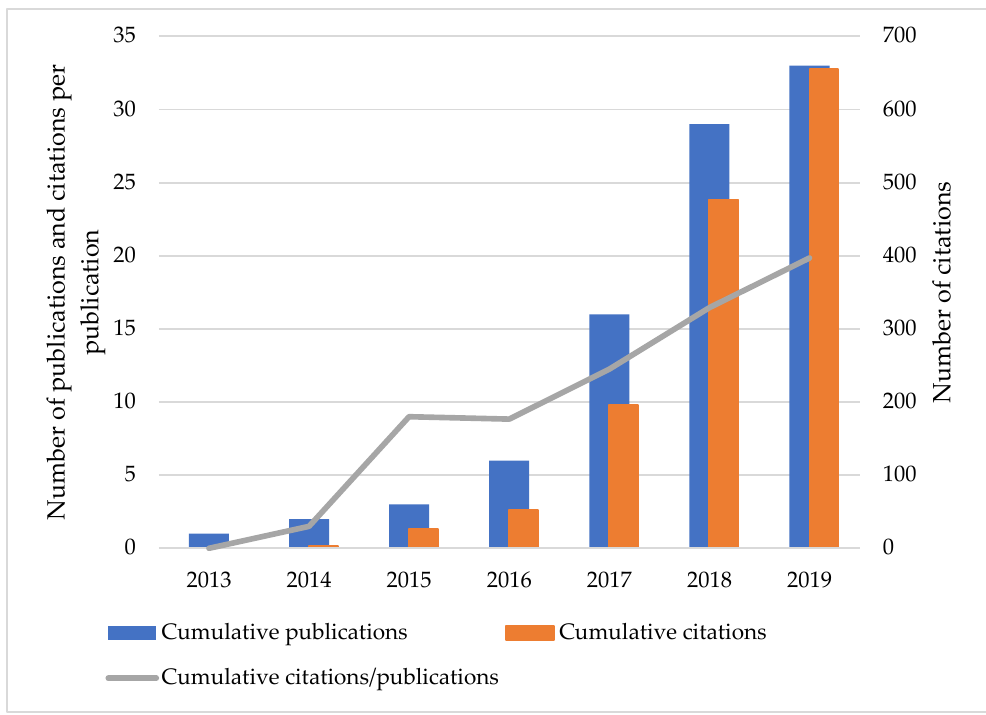
Figure 3 . Publications and related citations .